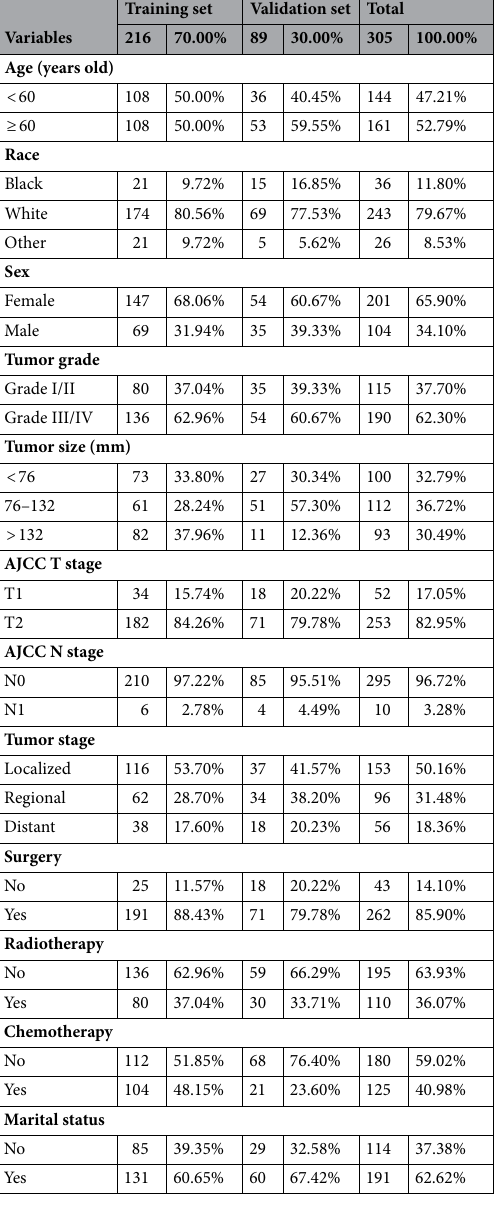
Table 1. The baseline demographics and clinical characteristics of patients with retroperitoneal leiomyosarcoma in this cohort retrospective